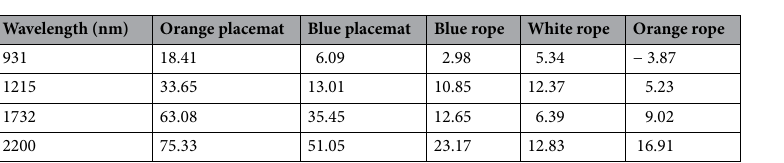
Table 2. Relative percentage loss in spectral reflectance, from dry to wet, placemats and